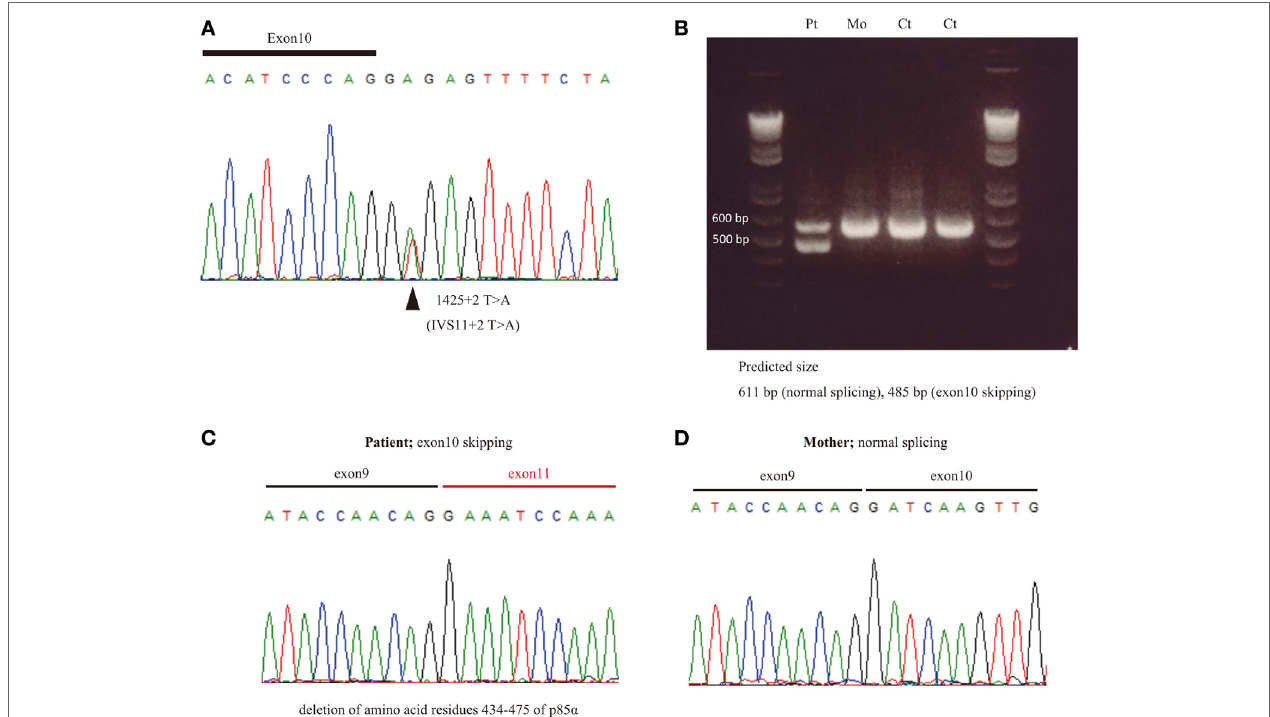
FigUre 1 | The effect of splice site mutation identified in P1. (a) A germline heterozygous mutation, (B) 1425 + 2 T > A, in PIK3R1 was identified by whole exome sequencing and confirmed by Sanger sequencing. (c) mRNA was extracted from peripheral blood mononuclear cells from P1 and his mother. Complementary DNA was then synthesized to assess the significance of the nucleotide substitution, 1425 + 2 T > A, on splicing. (c,D) The RT-PCR fragment was cloned into a pGEM-T easy vector. Loss of exon 10 in patient (c) but not mother (D) was revealed by Sanger